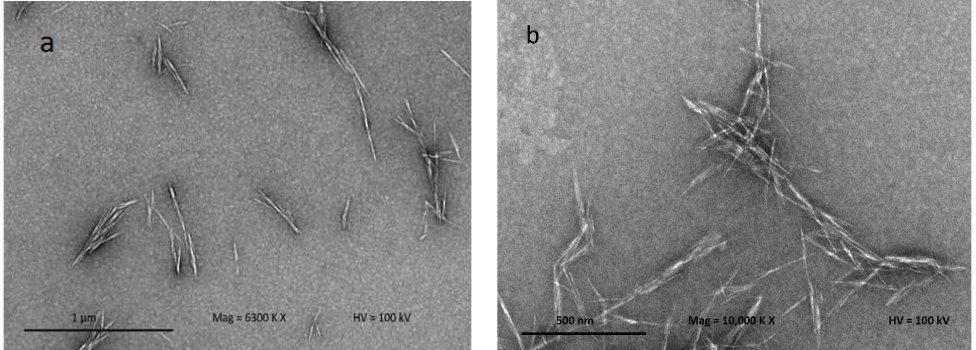
Figure 4. Transmission electron microscopy (TEM) micrographs of hydrolyzed kenaf under different magnifications: ( a ) 6300 × and ( b ) 10,000 × .